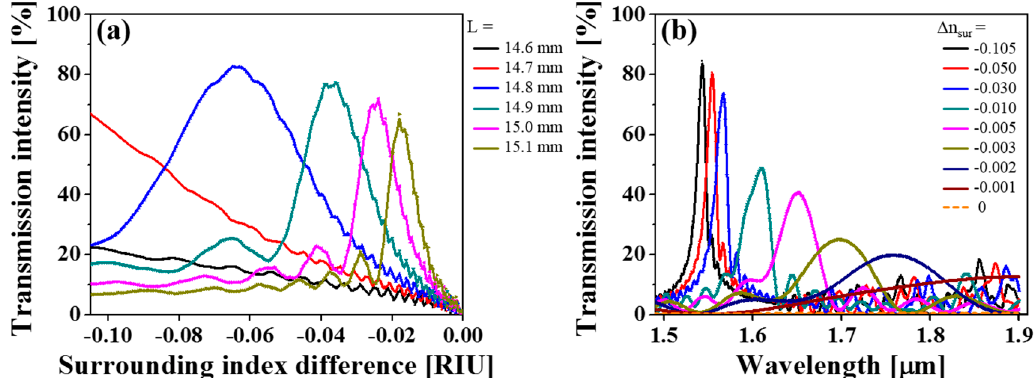
Figure 6. ( a ) Calculated transmission curves for the proposed sensor as a function of the surrounding index difference at λ = 1550 nm under different interaction lengths and ( b ) its spectral responses based on an SMF (UHNA1) with L = 14.8 mm.